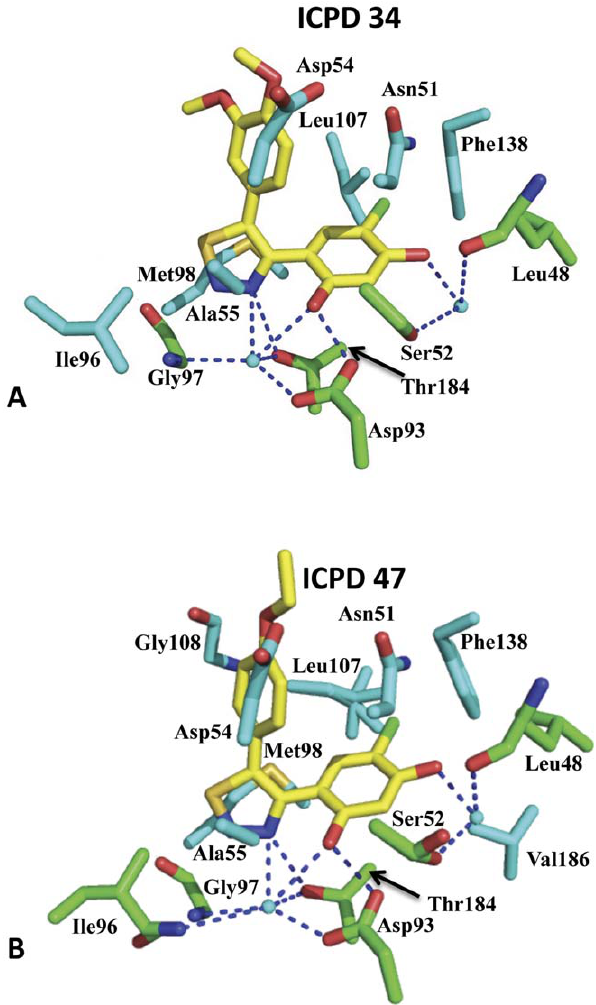
Figure 2. PyMOL diagram showing binding interactions with Hsp90. ( A ) Interactions of ICPD 34 and ( B ) ICPD 47 with the N-terminal domain of human Hsp90 a . Dotted blue lines represent hydrogen bonds and the amino-acid residues involved are in green; cyan-colored spheres represent water molecules and cyan residues are amino acids solely in van der Waals contact. The structures for ICPD 34, and ICPD 47 were obtained at 2.5, and 1.4 A ˚ resolution, respectively. ICPD 26, which lacks a 3-methoxy group relative to ICPD 34, binds in essentially the same manor as ICPD 34 and ICPD 47. For atomic coordinates and structure factors, see PDB codes 2YI0 (ICPD 26), 2YI5 (ICPD 34), and 2YI7 (ICPD 47).